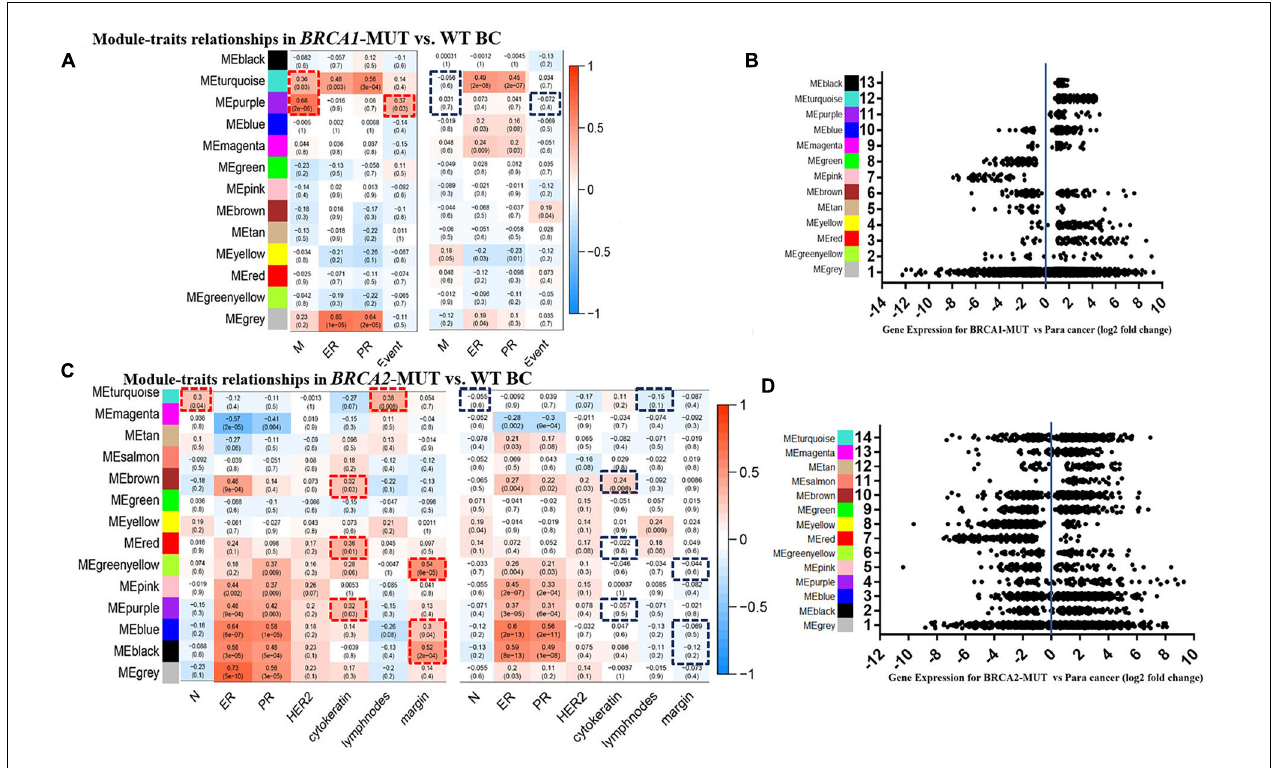
FIGURE 1 | Modules associated with clinical traits in BRCA1/2 -MUT and BRCA1/2 -WT BC, and expression levels of corresponding module genes. (A,C) Identification of consensus modules for BRCA1/2 -MUT and BRCA1/2 -WT BC; complete figures are shown in Supplementary Figure 4 . (B,D) Plot of gene expression levels for each consensus module of BRCA1 -MUT and BRCA2 -MUT BC to determine overall upregulation or downregulation of the module relative to normal tissue. N or M, the anatomic assessment of regional lymph node involvement or distant metastases. ER, status of estrogen receptor; PR, status of progesterone receptor; HER2, status of human epidermal growth factor receptor-2; lymph nodes, number of positive lymph nodes; ME, module eigengene. Negative ER, PR, or HER2 status was defined as “1” and positive status as “0.” Red frames, with significantly positive correlation in MUT; blue frames, lacking significant correlations in WT. TABLE 2 | Biological functions (from GO and pathway enrichment) in clinically significant modules.